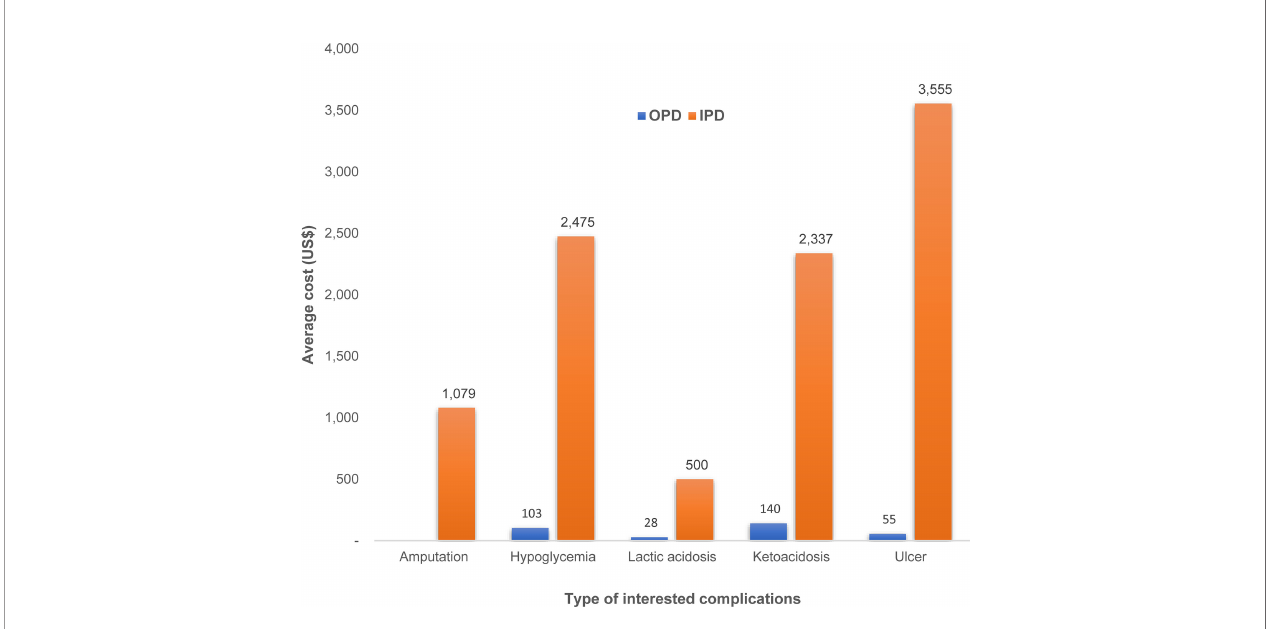
FIGURE 5 | Event-based treatment costs for type 2 diabetes related